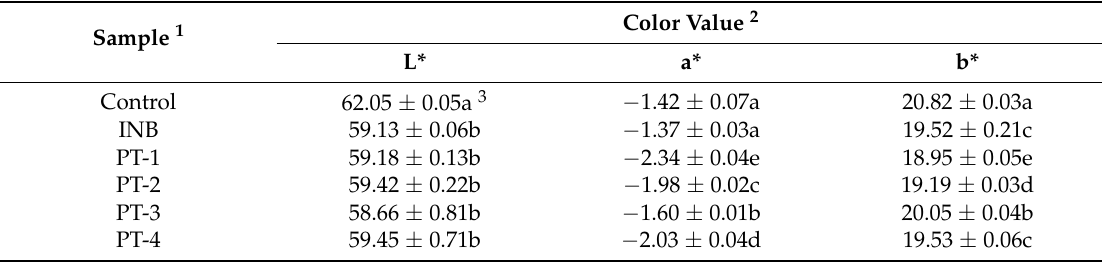
Table 2. Hunter’s color values of soybean sprouts cultivated with Indolbi (INB) or persimmon fruit powder